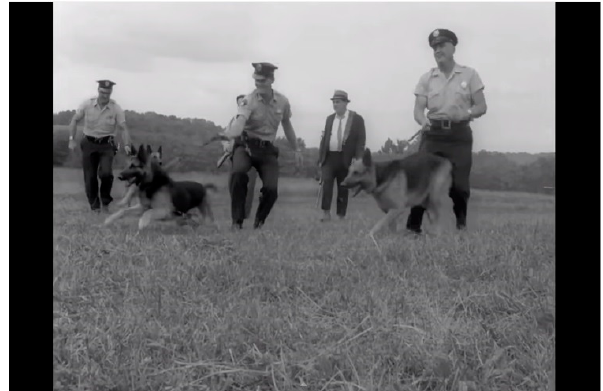
Figure 2. The zombie-clearing militia is led by the Sheriff—visible in the rear—and deputies. The German Shepherds add an unsettling familiarity to the imagery, invoking at once the threat of violence embodied in the presence of German Shepherds at Civil Rights demonstrations in the 1960s, as well as the historical use of dogs to track runaway slaves.